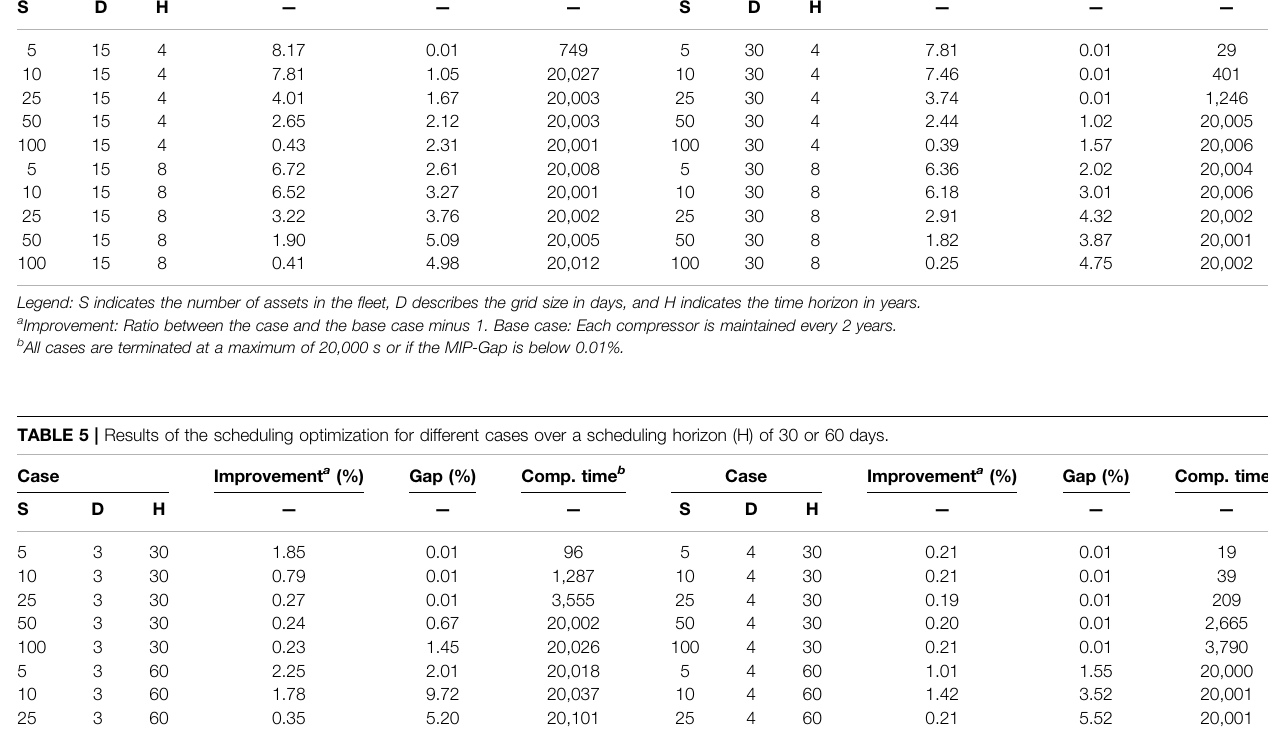
TABLE 4 | Results of the planning optimization for different cases over a planning horizon of 4 or 8 years.